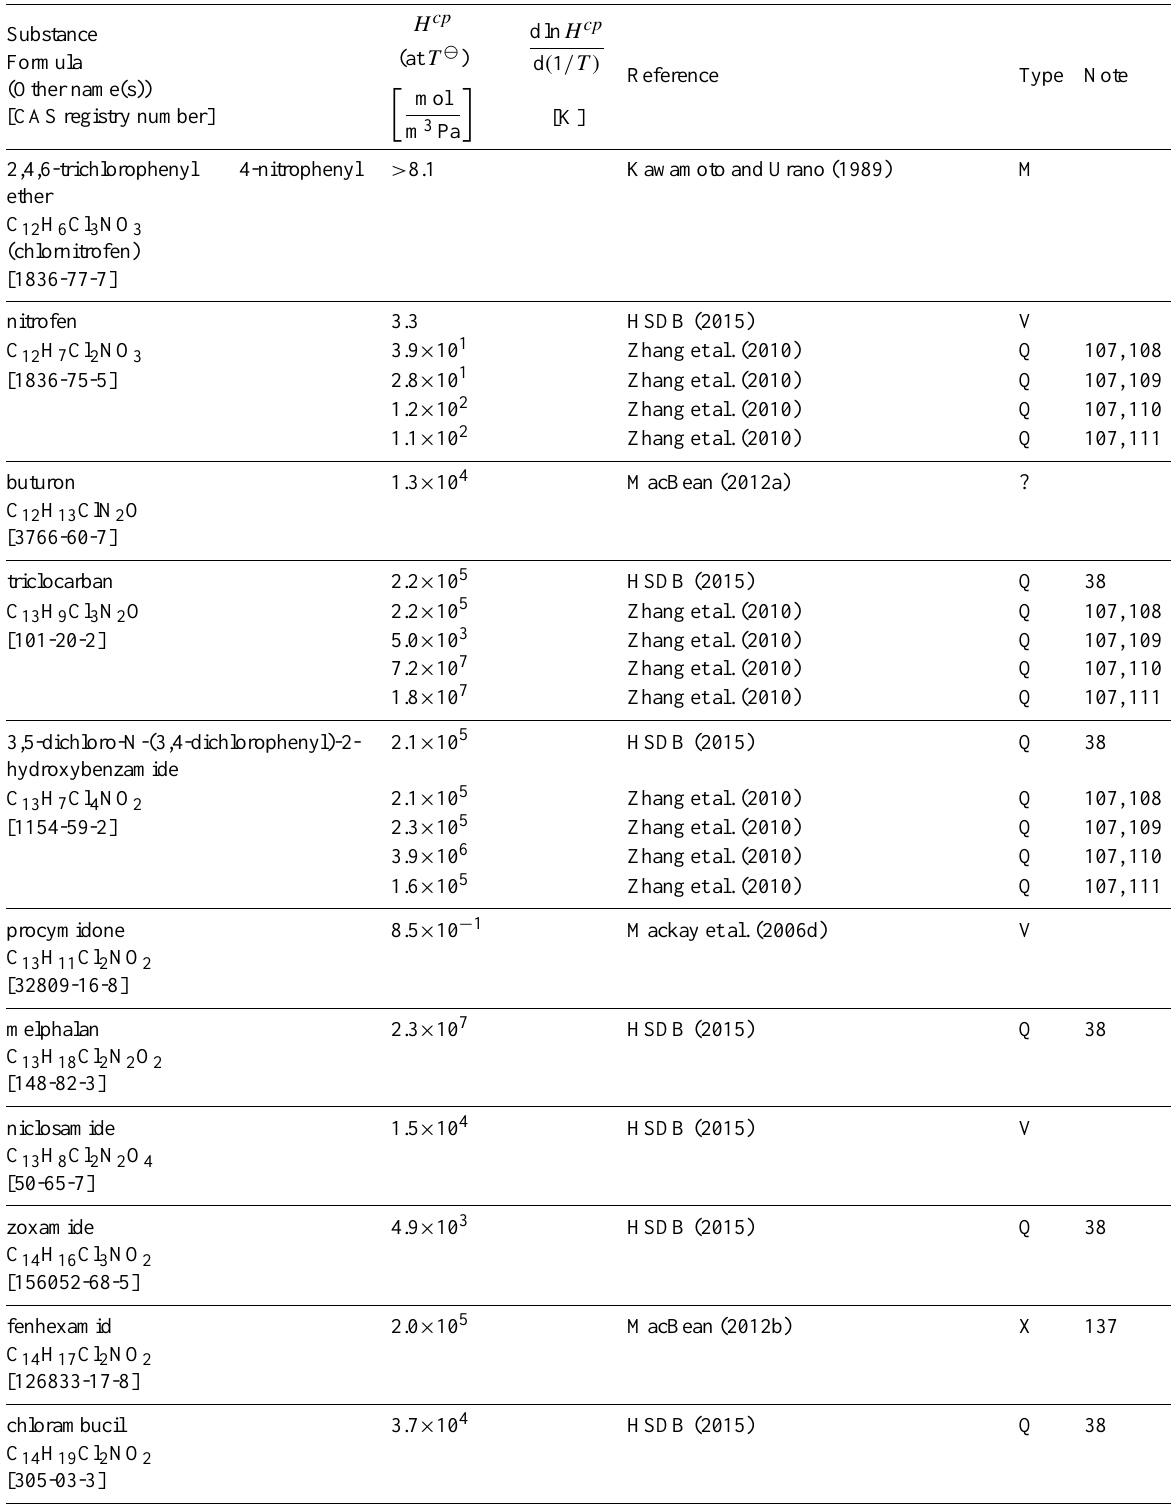
Table 6: Henry’s law constants for water as solvent